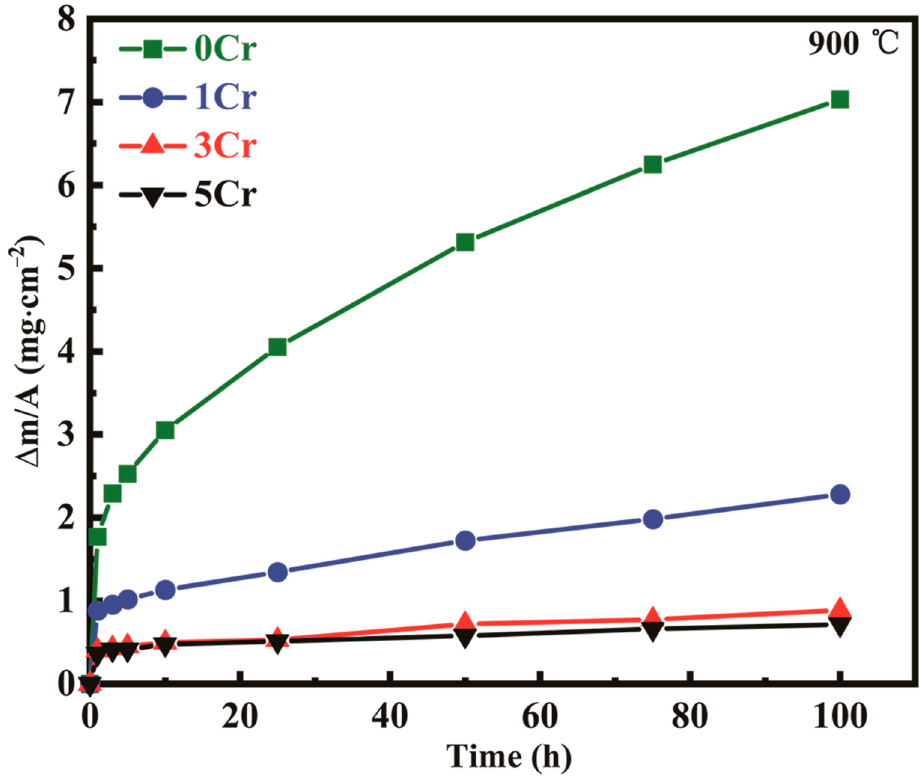
Δ Figure 2. Evolution of mass gain ( ∆ m / A ) with oxidation time of CoNi-based alloys (oxidized for Figure 2. Evolution of mass gain ( / m A ) with oxidation time of CoNi-based alloys (oxidized for 100 100 h).